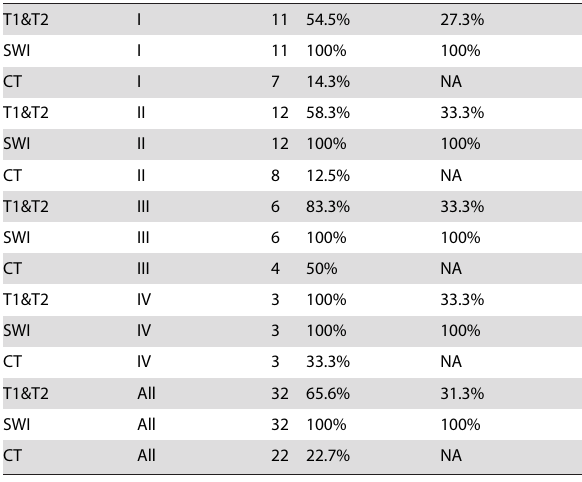
Table 2. Sensitivity and Accuracy by Cancer Grade.